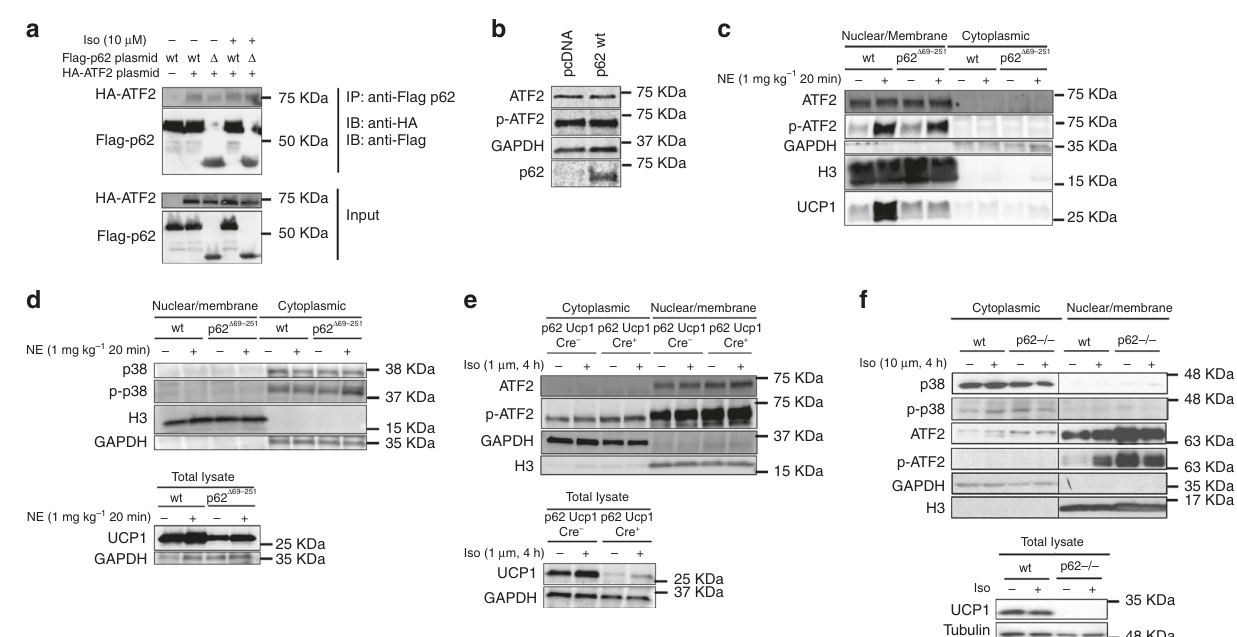
Fig. 6 p62 regulation of ATF2 nuclear target activation. Co-immunoprecipitation (IP) in HEK293T cells transfected with Flag-p62 wt, Flag-p62 Δ 69-251 , or HA-ATF2, respectively, and stimulated with isoproterenol as indicated. Flag-IP was performed to pulldown p62. Western blot analysis of pulldown (upper image) and input fraction (lower image) ( a ). Western blot analysis of ATF2 and p-ATF2 upon p62 overexpression in primary brown adipocytes isolated from 8-wk-old male p62 Δ 69-251 mice ( b ). Nuclear/membrane and cytosolic protein level of ATF2, p-ATF2 (Thr69/71), GAPDH, Histone 3 (H3), and UCP1 in BAT of 12-wk-old male wt and p62 Δ 69-251 mice upon injection of norepinephrine (1 mg kg − 1 ) for 20 min ( c ). Nuclear/membrane and cytosolic protein level of p38, p-p38, GAPDH, Histone 3 (H3) as well as total lysates showing UCP1 in BAT of male wt and p62 Δ 69-251 mice upon injection of norepinephrine (1 mg kg − 1 ) for 20 min ( d ). Nuclear/membrane and cytosolic protein level of ATF2, p-ATF2 (Thr69/71), GAPDH, Histone 3 (H3) as well as total lysates showing UCP1 upon 4 h stimulation with 1 µ M isoproterenol in immortalized brown adipocytes from 6- to 8-wk-old male p62 fl x/ fl x Ucp1-Cre − or p62 fl x/ fl x Ucp1-Cre + mice ( e ). Nuclear/membrane and cytosolic protein level of p38, p-p38, ATF2, p-ATF2 (Thr69/71), GAPDH, Histone 3 (H3) as well as total lysates showing UCP1 upon 4 h stimulation with 10 µ M isoproterenol in immortalized brown adipocytes from wt or p62 − / − mice ( f ). Panel ( a ) represents a representative example of three independently performed studies, each yielding similar results. Panels ( b ), ( c ), ( d ), and ( f ) are representative examples of two independently performed studies, each yielding similar